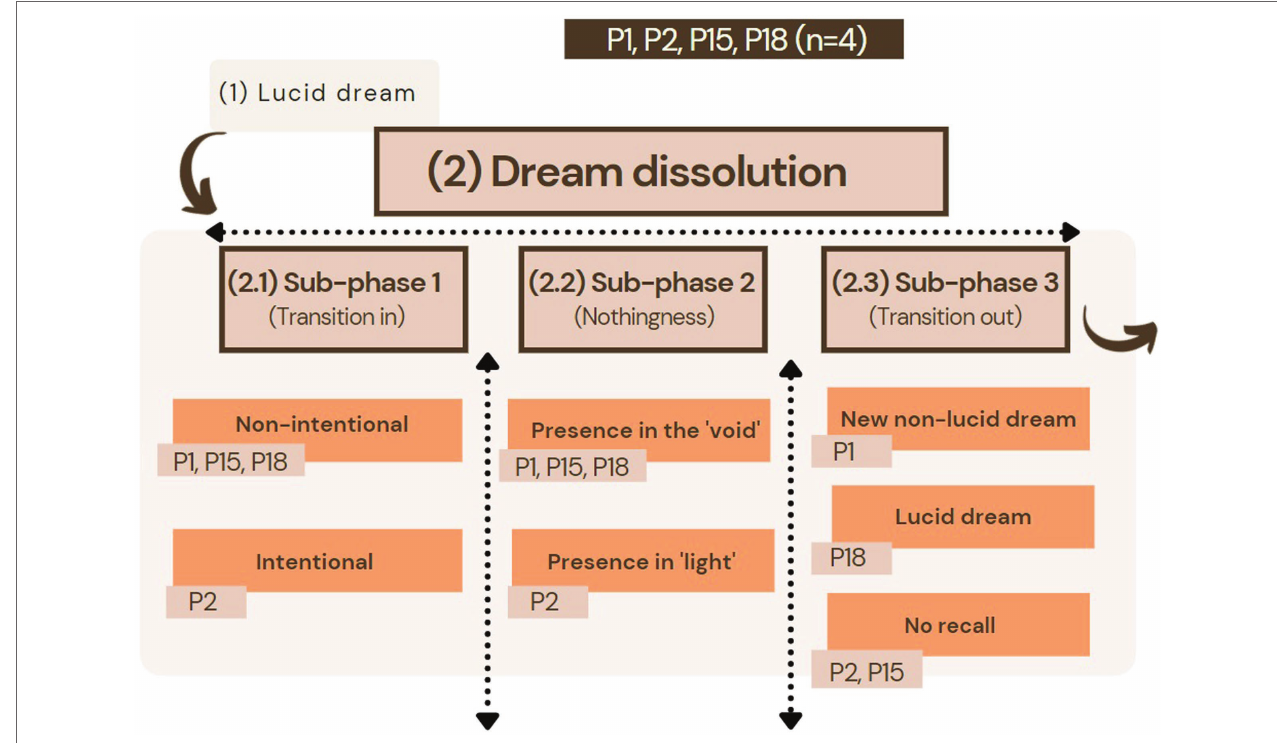
FIGURE 2 | Diachronic structure 1 was characterized by the experience of the dissolution of a lucid dream preceding the sub-phase “nothingness” in participants P1, P2, P15, and P18 ( n = 4). This sub-phase can be reached intentionally or